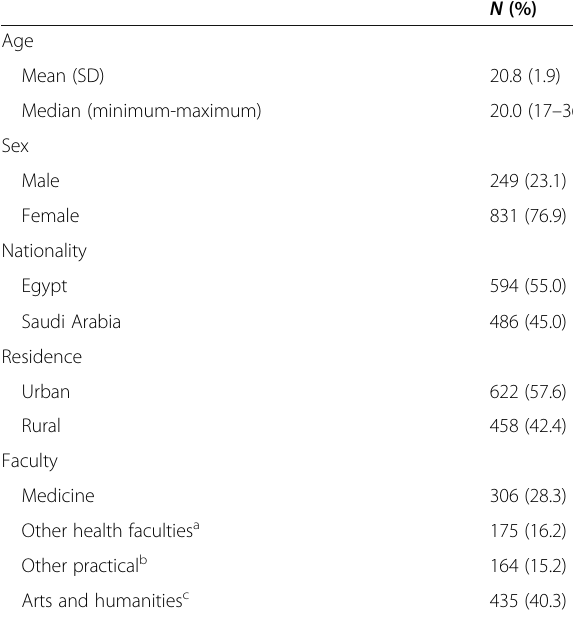
Table 2 Sociodemographic characteristics of studied students (1080)